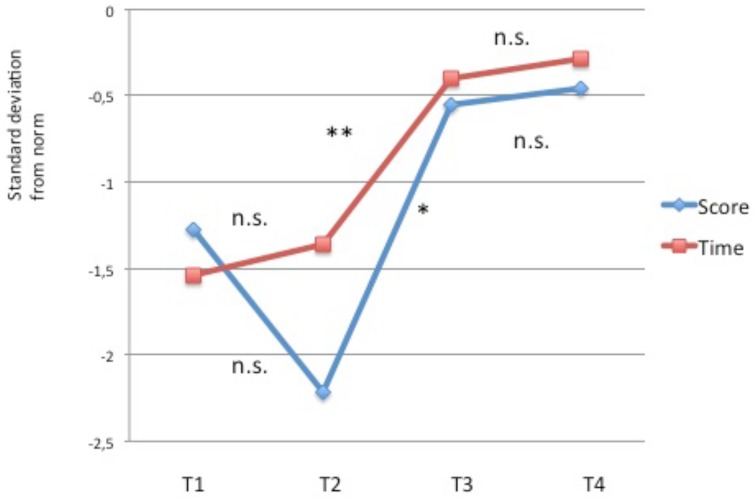
Comparison of letter strings (in standard deviations from age-norm). Evolution of the level of performance across time. Significant improvements from T2 to T3 for speed (Time: **p < 0.01; *p < 0.05) but marginally significant for accuracy (score: *p < 0.05).